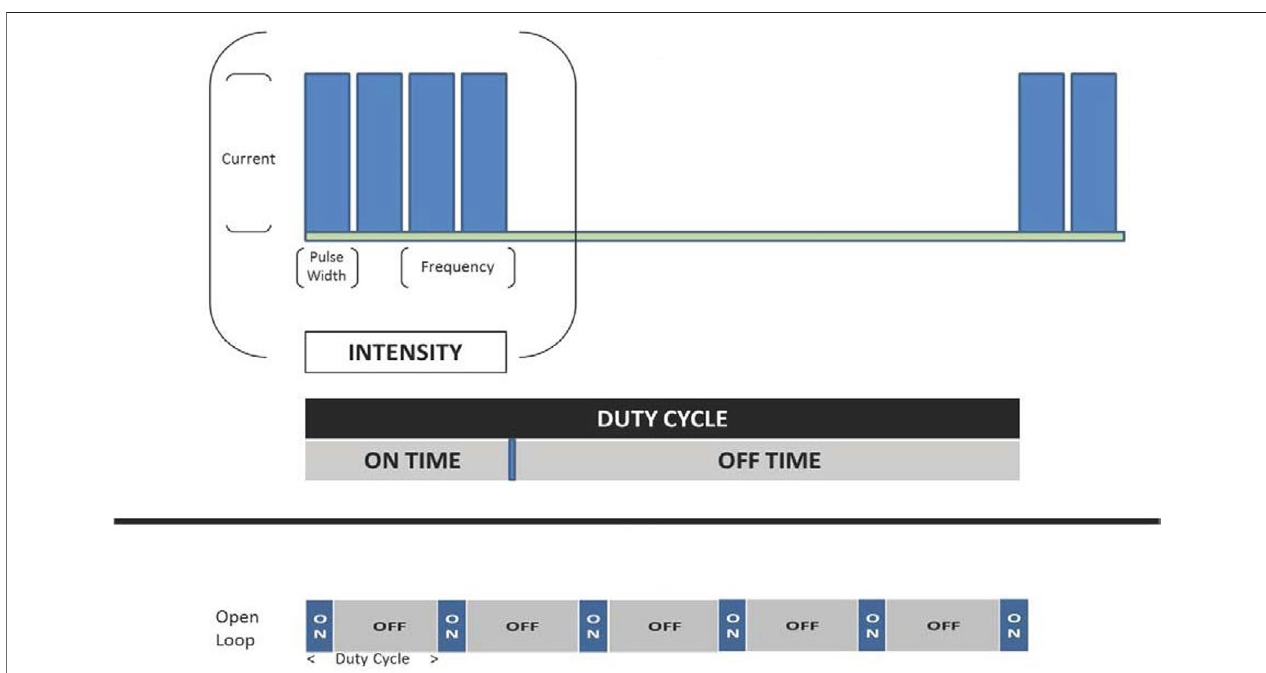
FIGURE3| VNSintensityencompassesacombinationofpulse amplitude(current),pulsefrequency, pulseduration,and dutycycle.Adapted fromAnandIS,etal. Int J Neurol Neurother 2019 with permission.